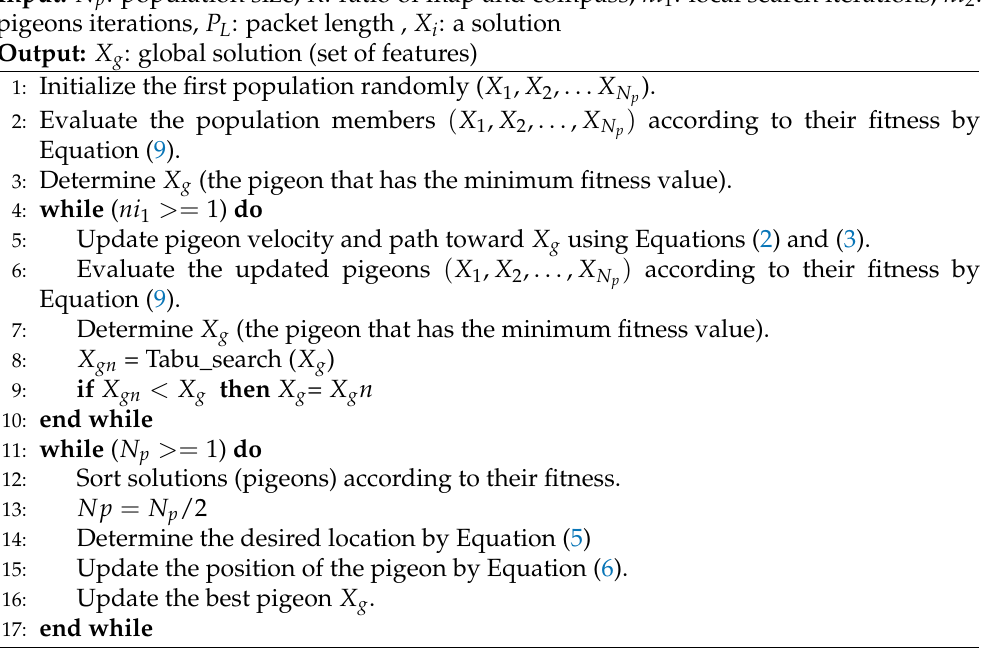
Algorithm 1 Hybrid intelligent DNS tunneling detection system based on (Tabu-PIO and packet length)